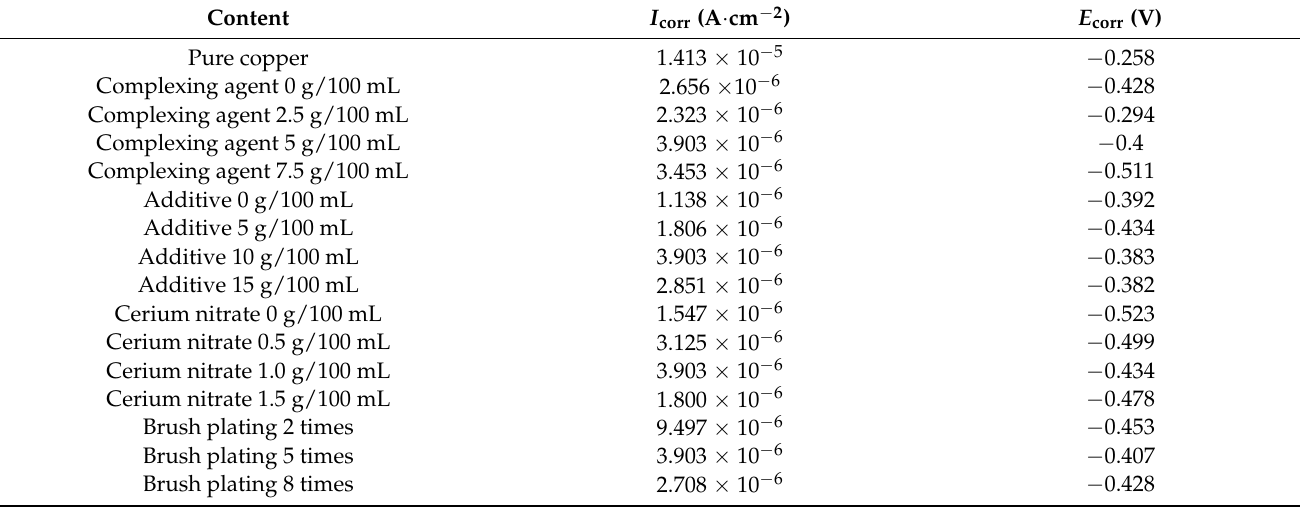
Table 2. Corrosion current and corrosion voltage of tin plating under different influencing factors.